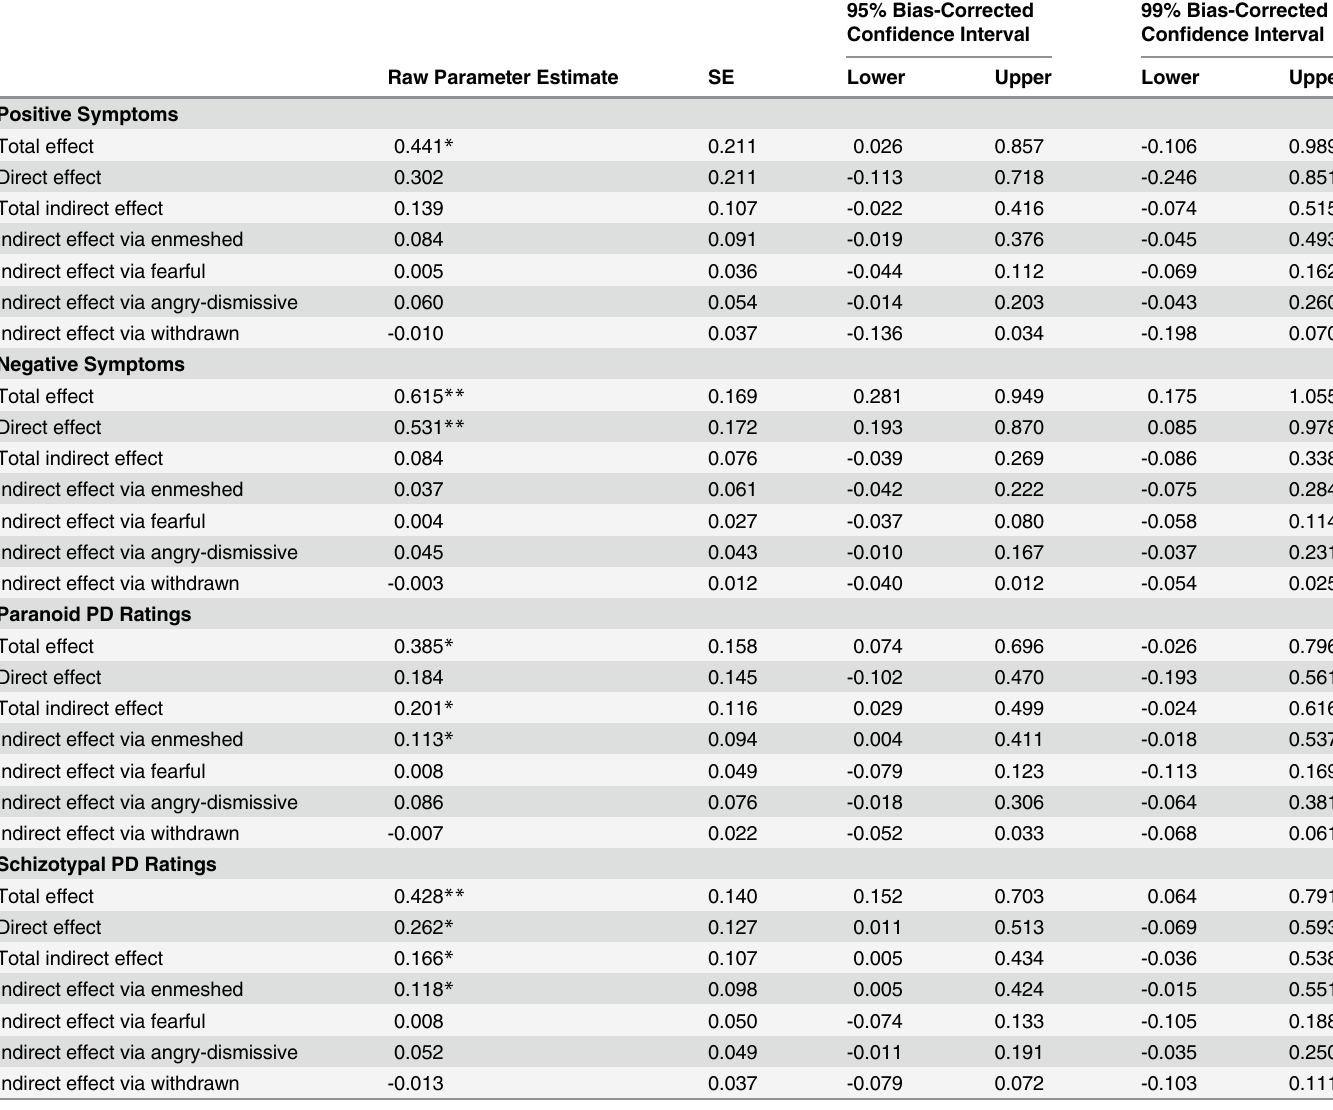
Table 5. Mediation Analyses Examining Indirect Effects of Role Reversal on Schizophrenia-Spectrum Phenomenology via Enmeshed, Fearful, Angry-Dismissive, and Withdrawn